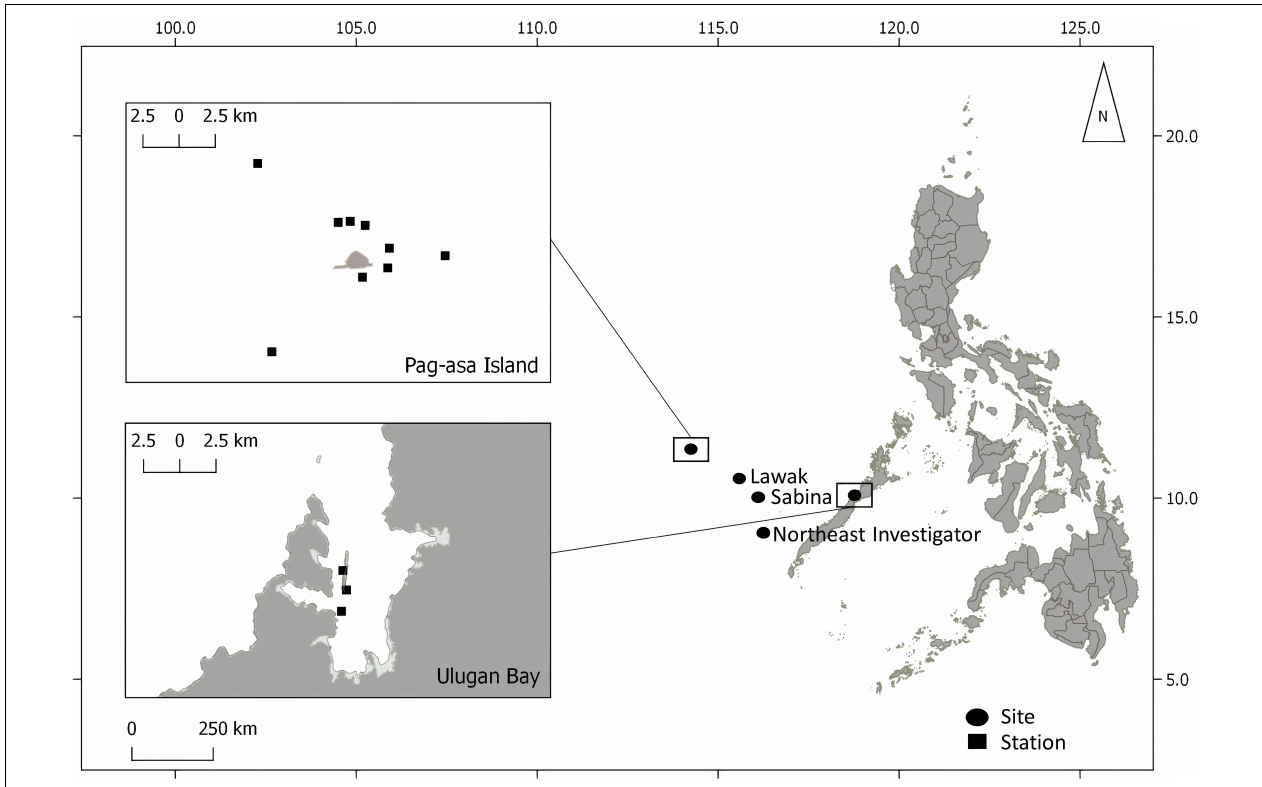
FIGURE 1 | Study sites and stations in the Kalayaan Island Group (Pag-asa, Sabina, Lawak and Northeast Investigator) and Ulugan in the West Philippine Sea surveyed in 2017 and 2019. Insets show stations in Pag-asa and Ulugan.